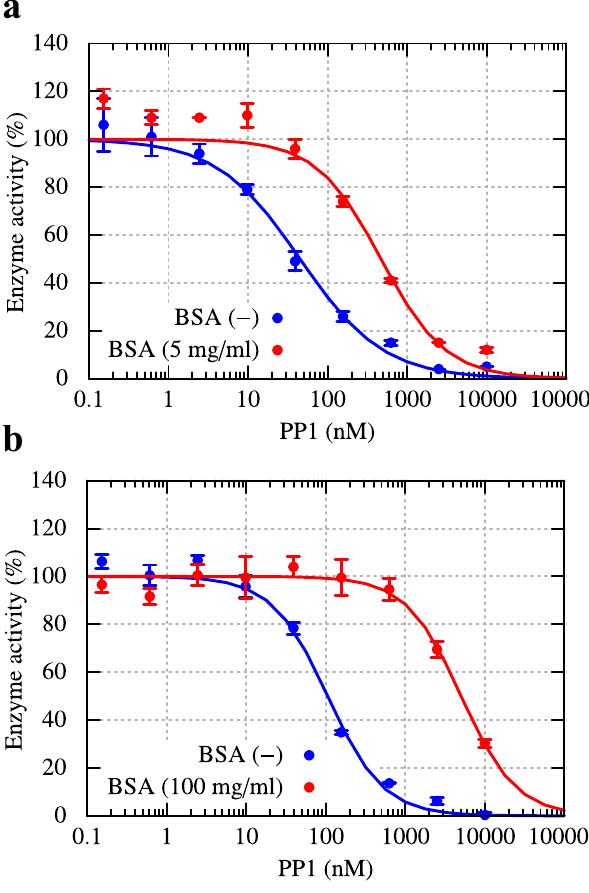
Fig. 3 Reduced ef fi cacy of PP1 inhibitor in the presence of the crowder (BSA) proteins. a Enzymatic activity of c-Src kinase in the dilute solution ([c-Src] = 65.7 nM) and in the crowded solution with BSA (5 mg/ml). b The same experiment except for the concentration of BSA (100 mg/ml) in the crowded solution and those of DMSO (0.2% and 1.0% in the fi rst and second experiments, respectively). In both crowded solutions, the concentration of c-Src kinase is [c-Src] = 65.7 nM. Error bars represent the standard deviation of the mean from three independent assays,